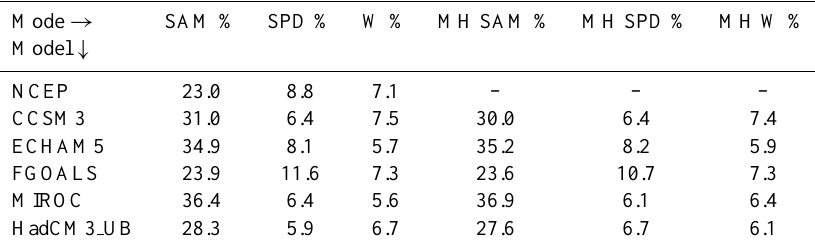
Table 3. The variability described by the three leading EOFs for the NCEP model and the pre-industrial control phase of the PMIP2 models (columns 2–4) and for the PMIP2 models for the Mid-Holocene (columns 5–7, denoted MH). Mode → SAM % SPD % W % MH SAM % MH SPD % MH W % Model ↓ NCEP 23.0 8.8 7.1 – – – CCSM3